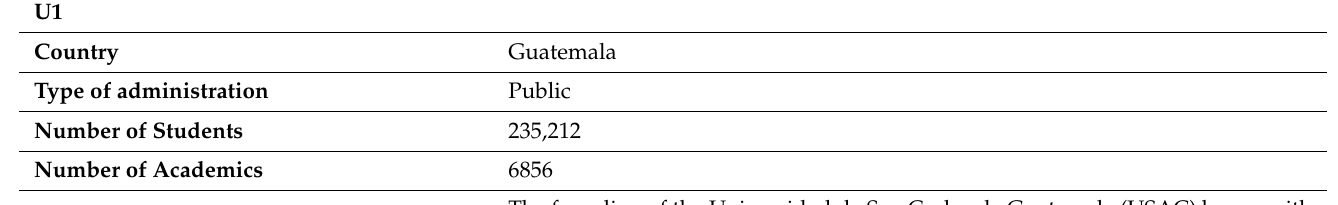
Table A8. Information from all the institutions participating in the